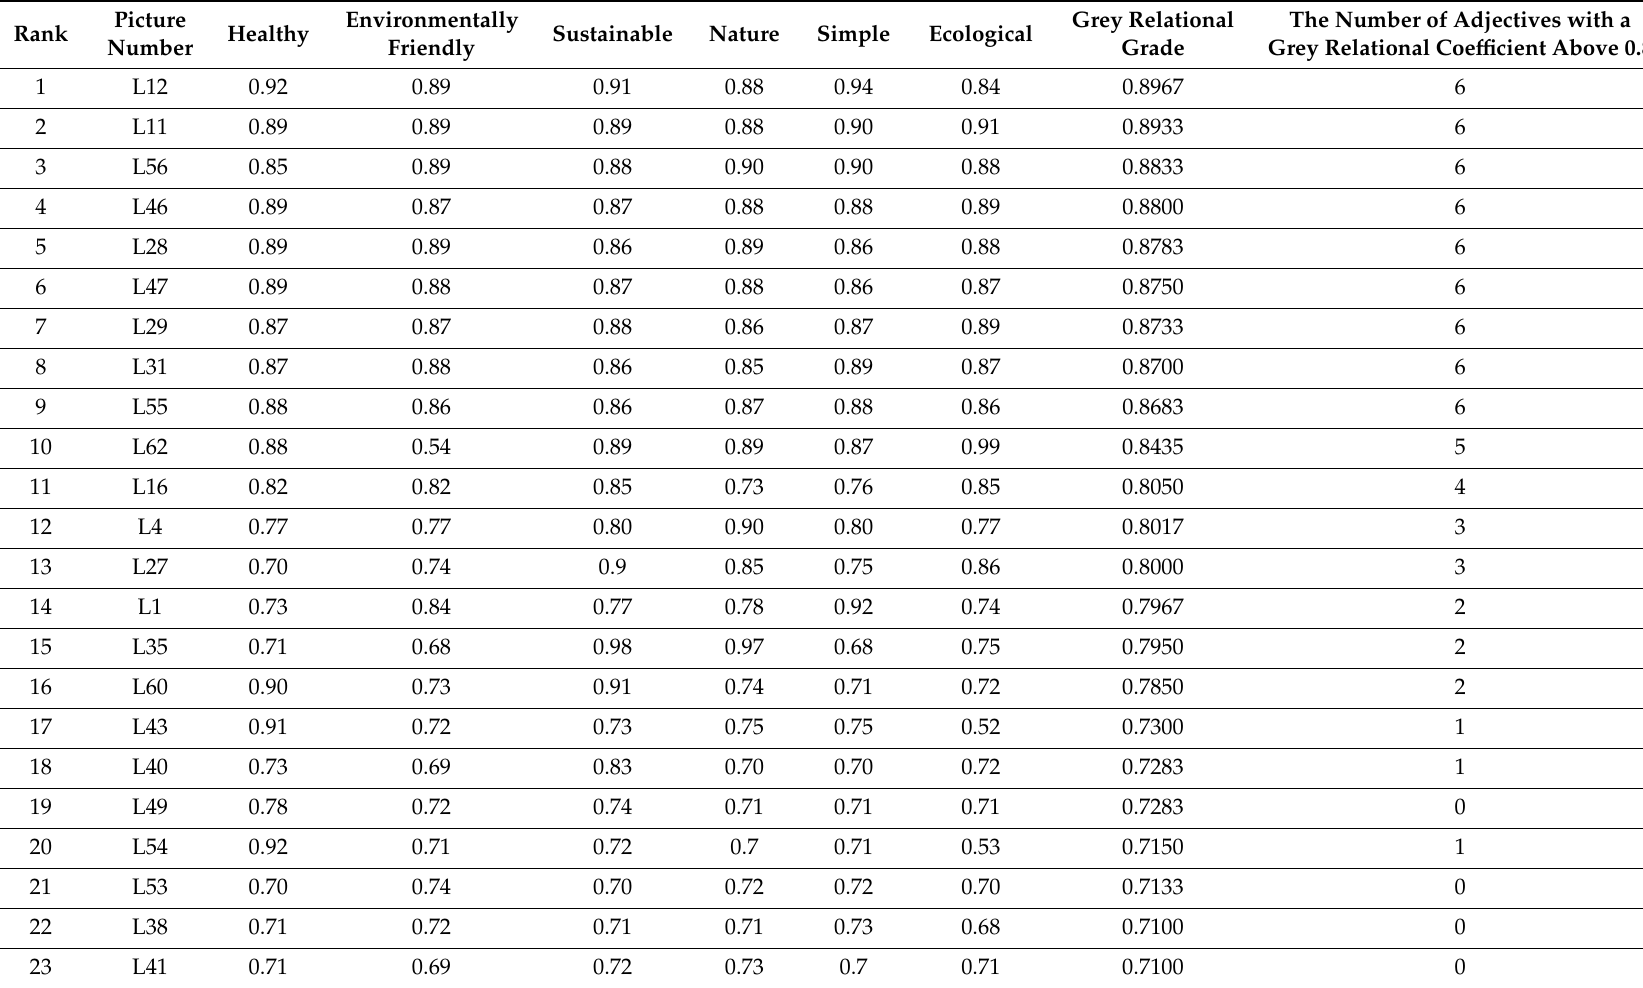
Table 3. Result of the